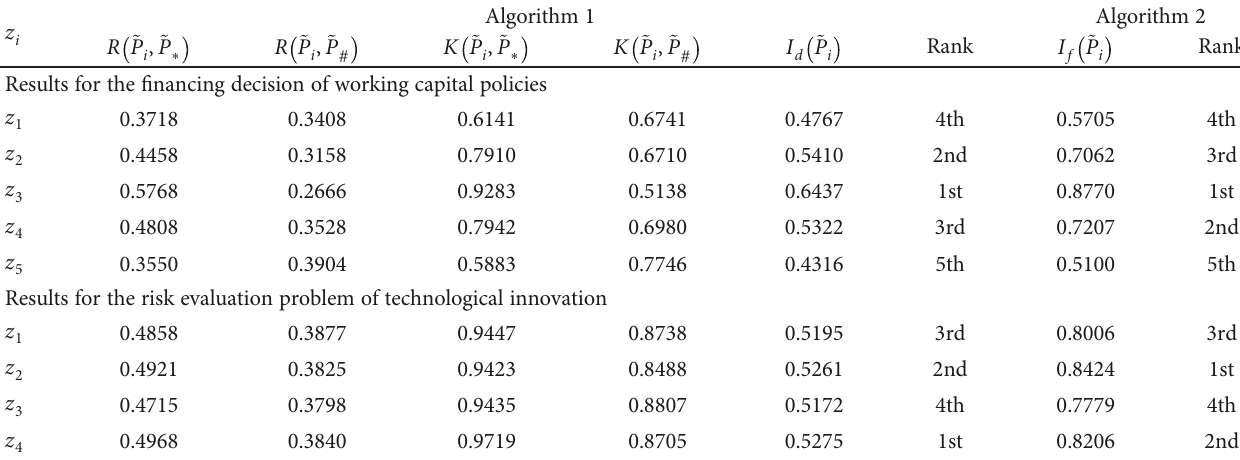
Table 5: Selected results in other application fi elds. Algorithm 1